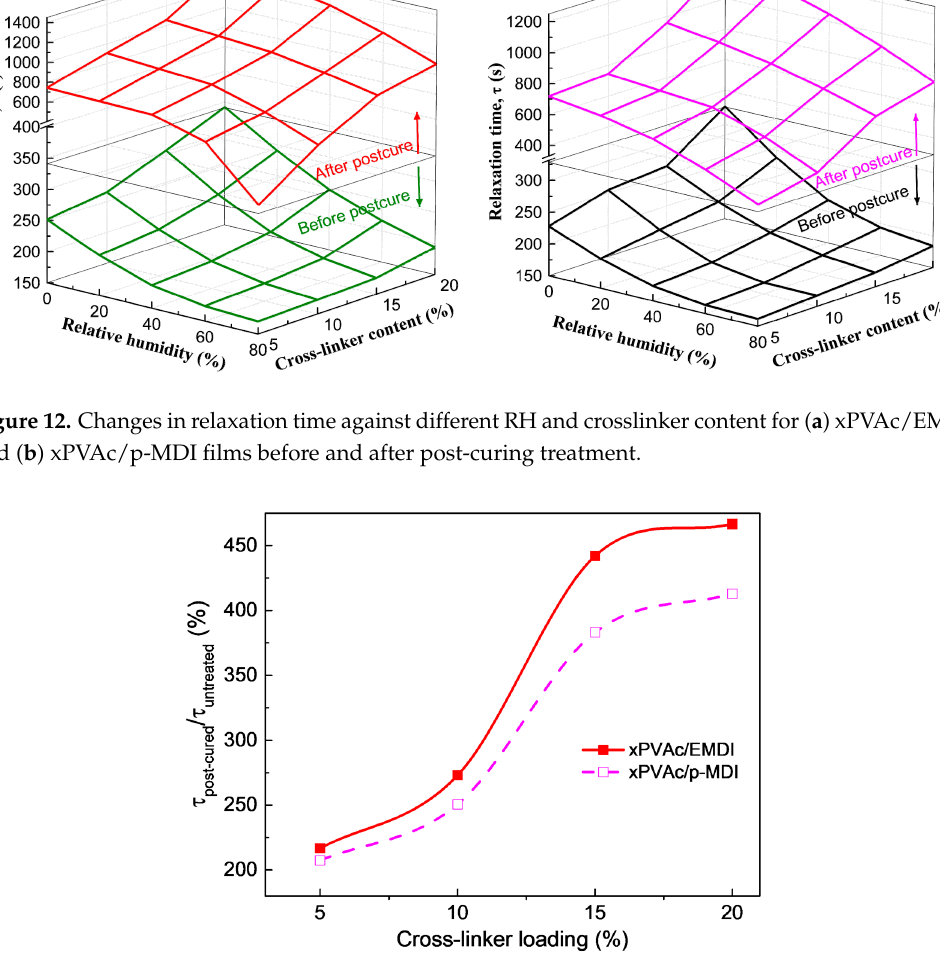
Figure 13. Effect of cross-linker loading on ratio of relaxation time for post-cured EPI film after and before post-cure.